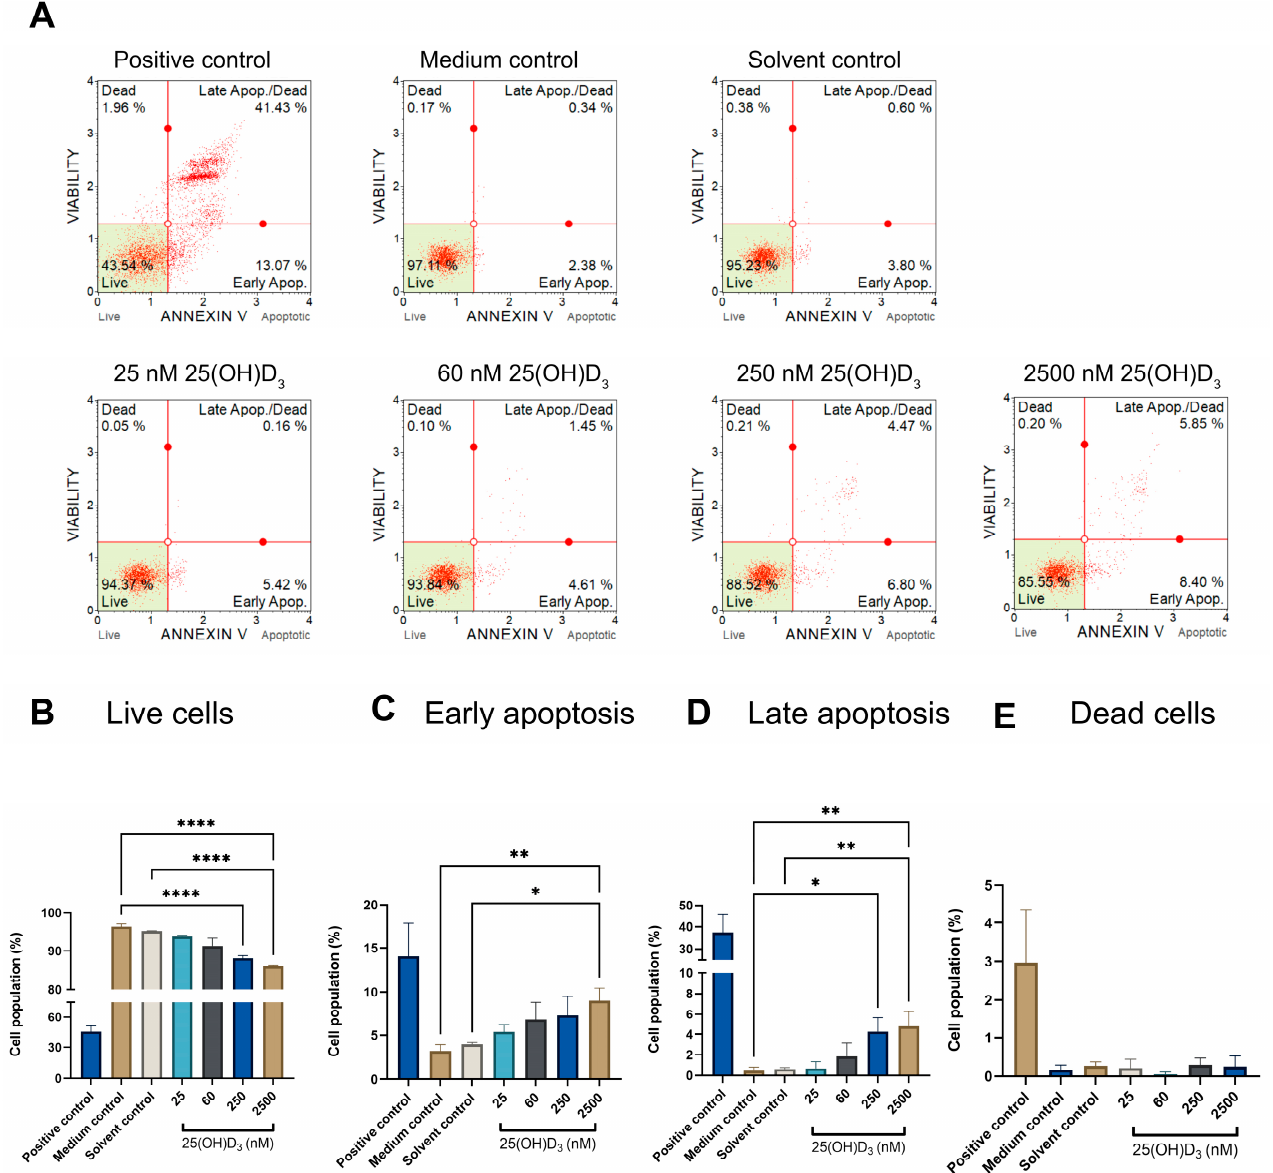
Figure 4. Identification of phosphatidylserine externalisation to the cell membrane’s surface was detected by flow cytometry using the annexin V assay. The dot plots of control and experimental SiHa cells ( A ), were analysed by bar graphs that differentiated the live cell population ( B ) from early apoptosis ( C ), late apoptosis ( D ), and dead cell ( E ) populations. The positive control was treated with actinomycin to a final concentration of 0.1 µ g/mL. Data are expressed as mean ( ± SEM) from three independent experiments, each performed in triplicate (* p ≤ 0.05; ** p ≤ 0.01; **** p ≤